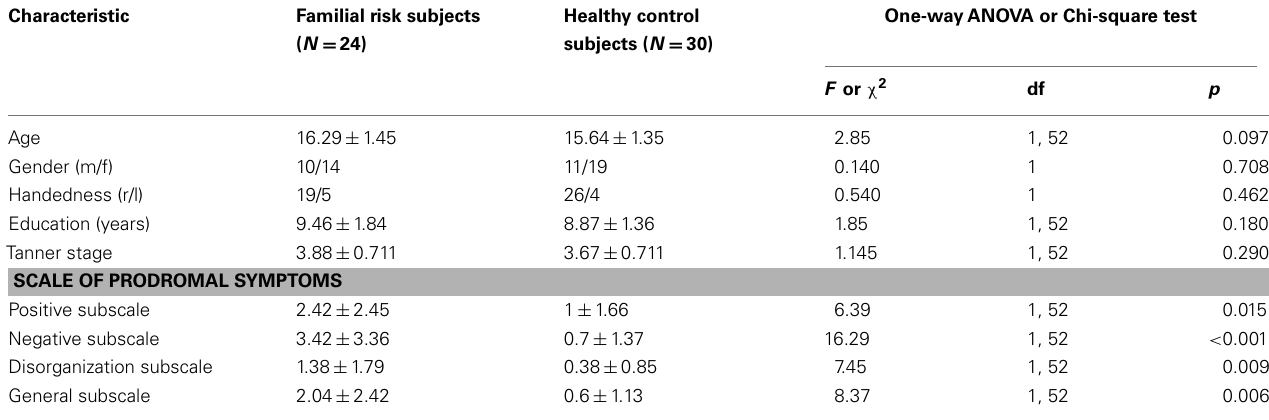
Table 1 | Demographic and clinical characteristics of study